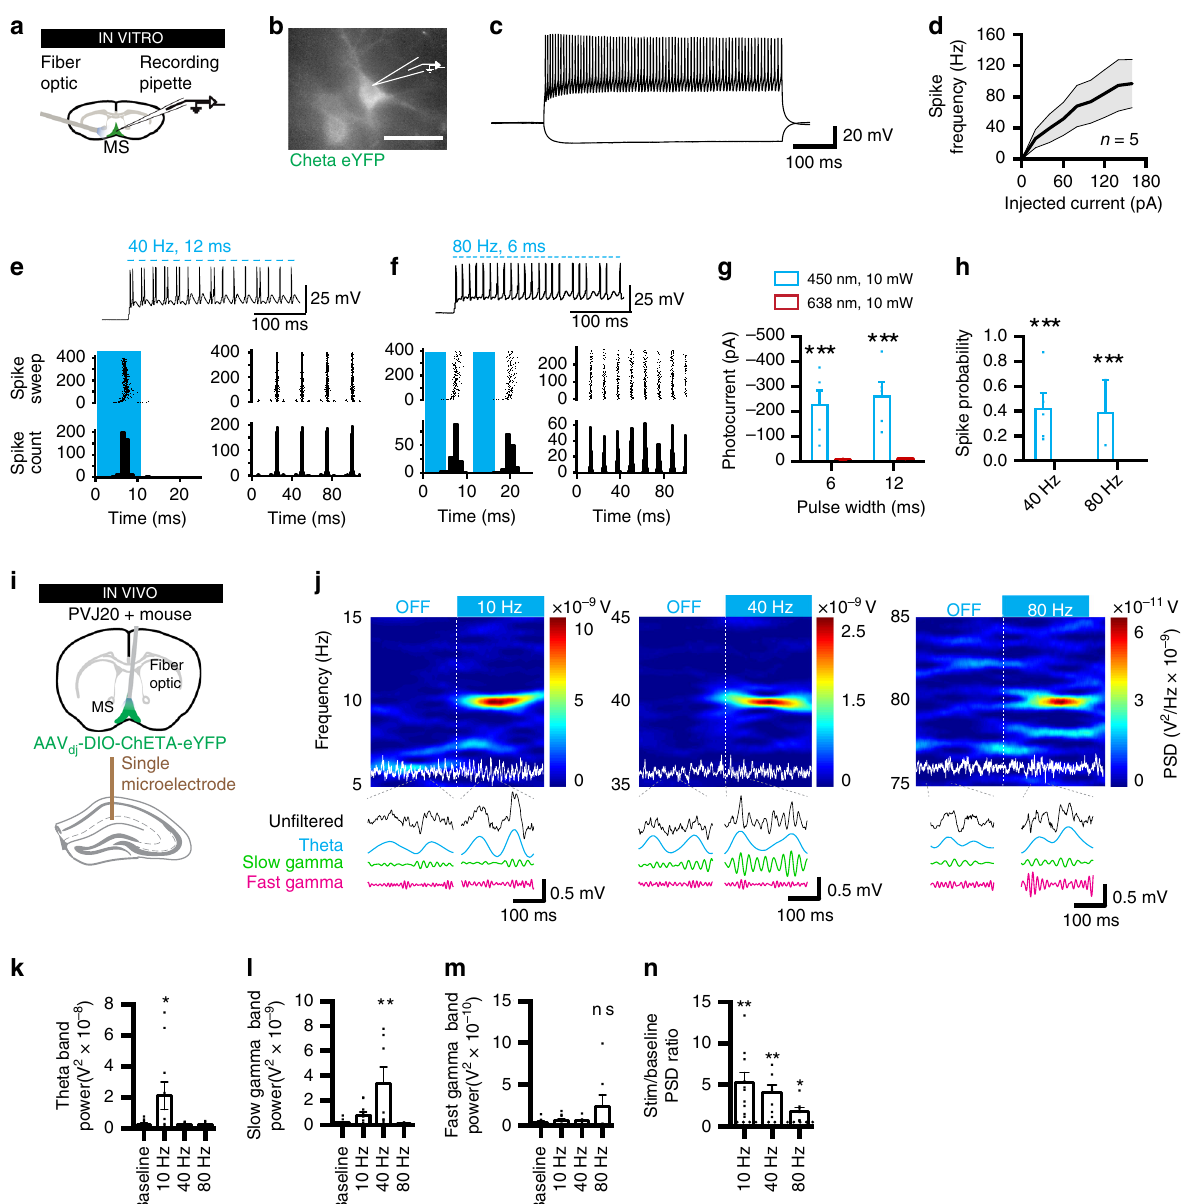
Fig. 2 Optogenetic control of medial septum parvalbumin cells can increase gamma oscillations in PVJ20 + mice. a In vitro recording con fi guration. b Example eYFP-ChETA + MSPV neuron visually identi fi ed. Scale bar: 50 μ m. c Fast-spiking response of MSPV cell in response to injected current